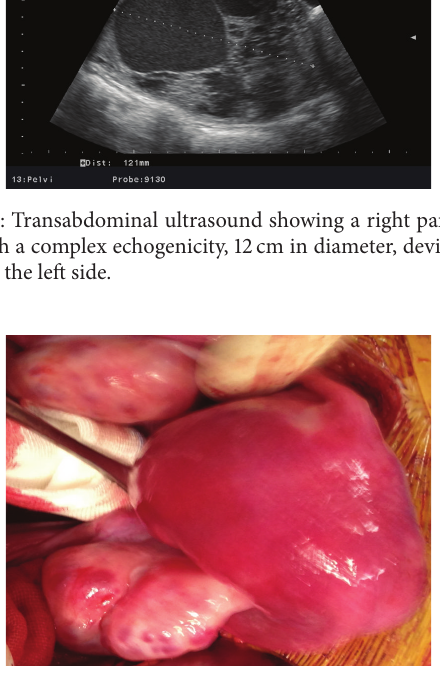
Figure 2: Laparotomy. A clear cleavage plane allows the dissection of the uterine mass from the underlying uterine myometrium. Anteriorly, the mass is dissected from the bladder and the right ureter, to the vaginal wall of the lateral right